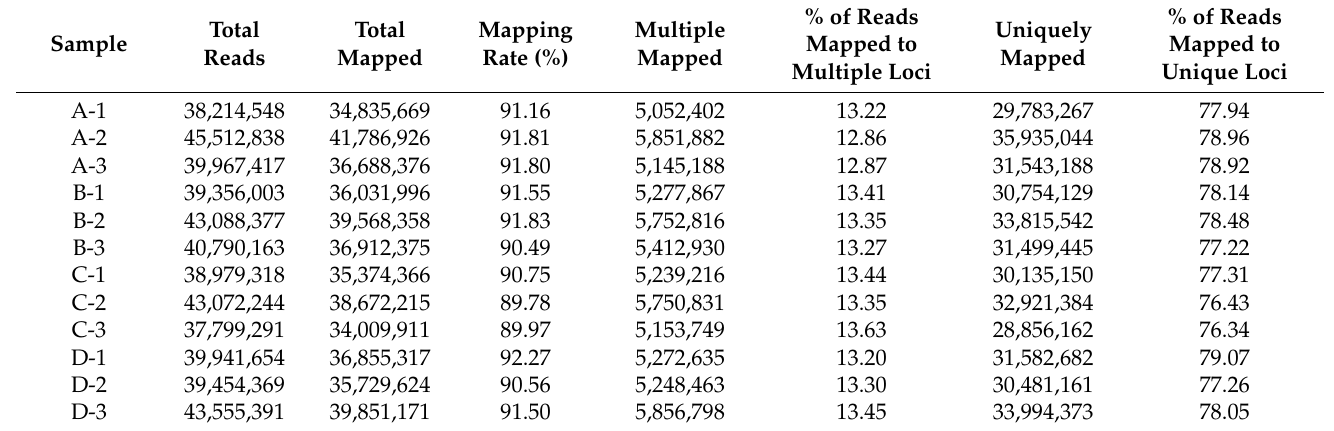
Table 3. Mapping of wild jujube transcriptome to reference genes.